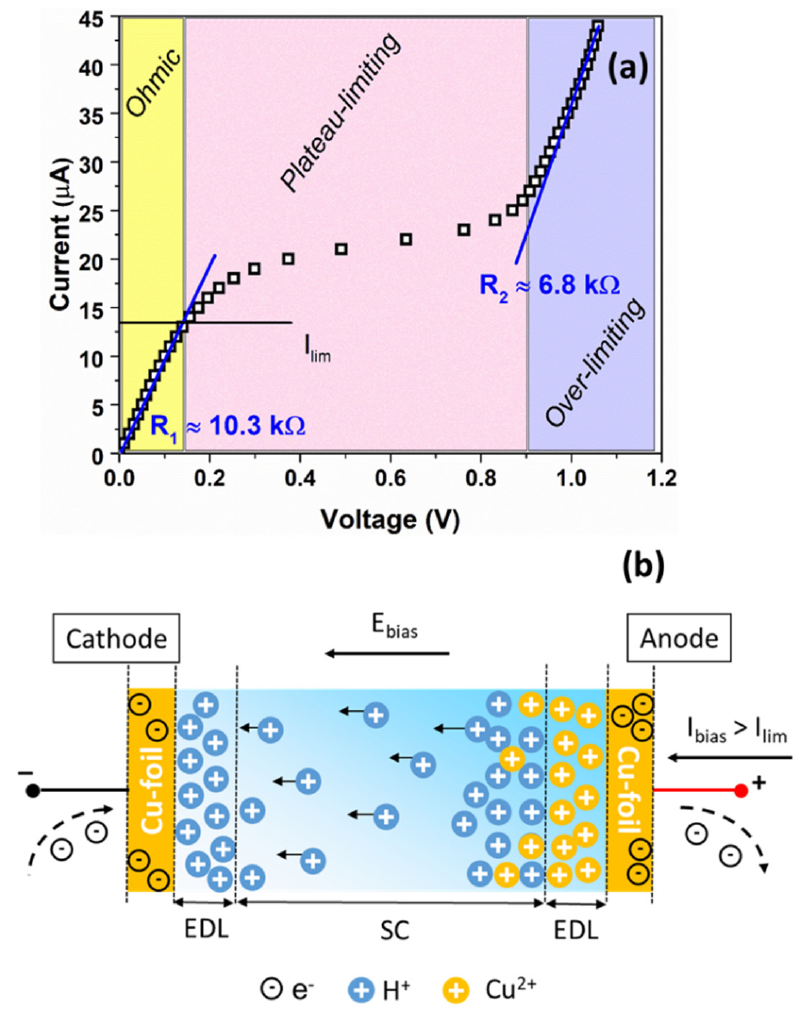
Figure 6. ( a ) Current–voltage characteristic of the temperature sensor under current biasing and ( b ) schematic illustration representing the charge accumulation and faradaic processes within the blend when I bias > I lim .